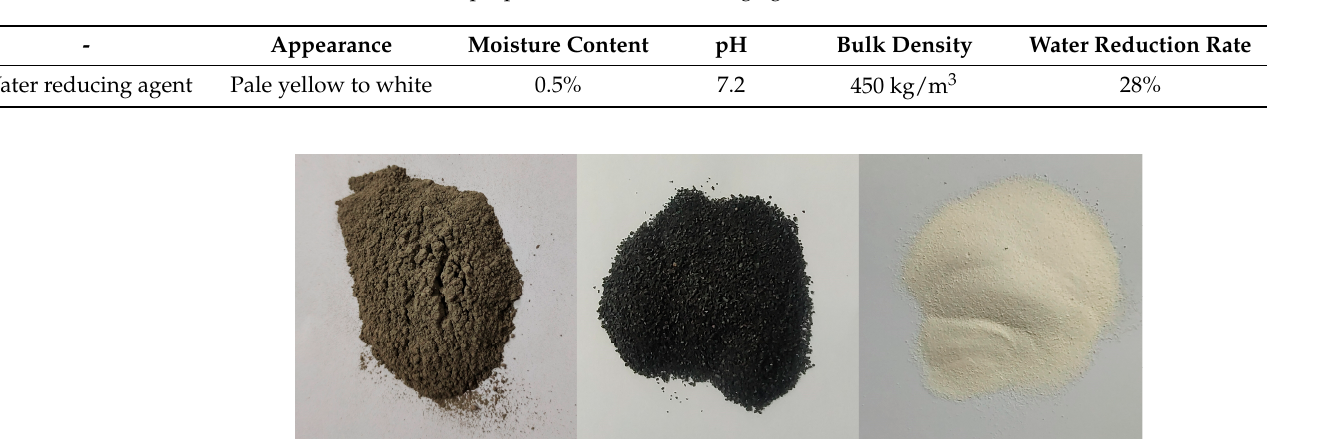
Table 3. The main properties of water reducing agent.